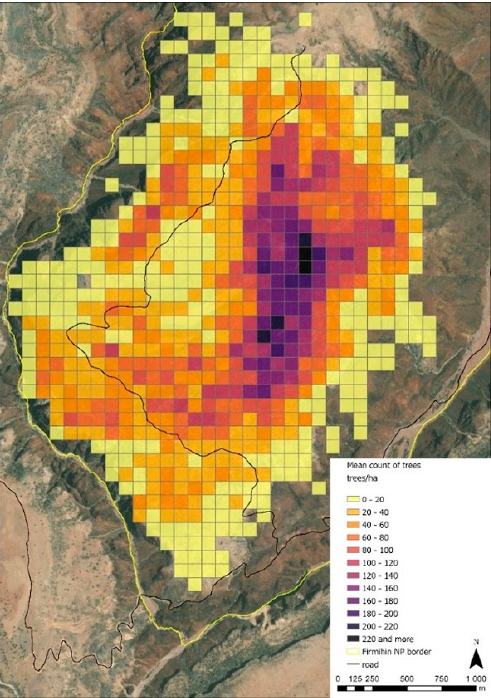
Figure 6. Spatial distribution of Dracaena tree density in Firmihin (individual trees /ha).